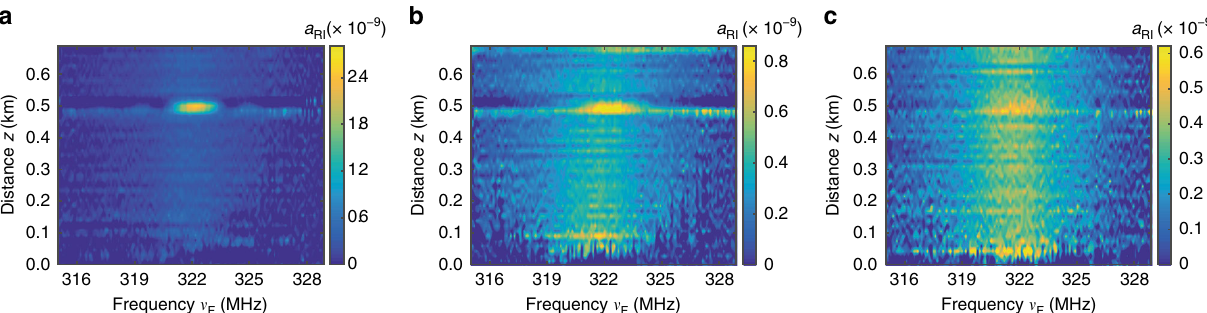
Fig. 6 Results of the distributed measurements of forward stimulated Brillouin scattering. Distributed spectra of forward stimulated Brillouin scattering (FSBS) measured over the 730 m-long sensing fi bre when the 30 m uncoated fi bre segment is exposed to a air, b ethanol, and c water. The FSBS responses represented by the local amplitudes of refractive index changes a RI ( z ) could be clearly observed in the exposed fi bre regions (0.5 km)